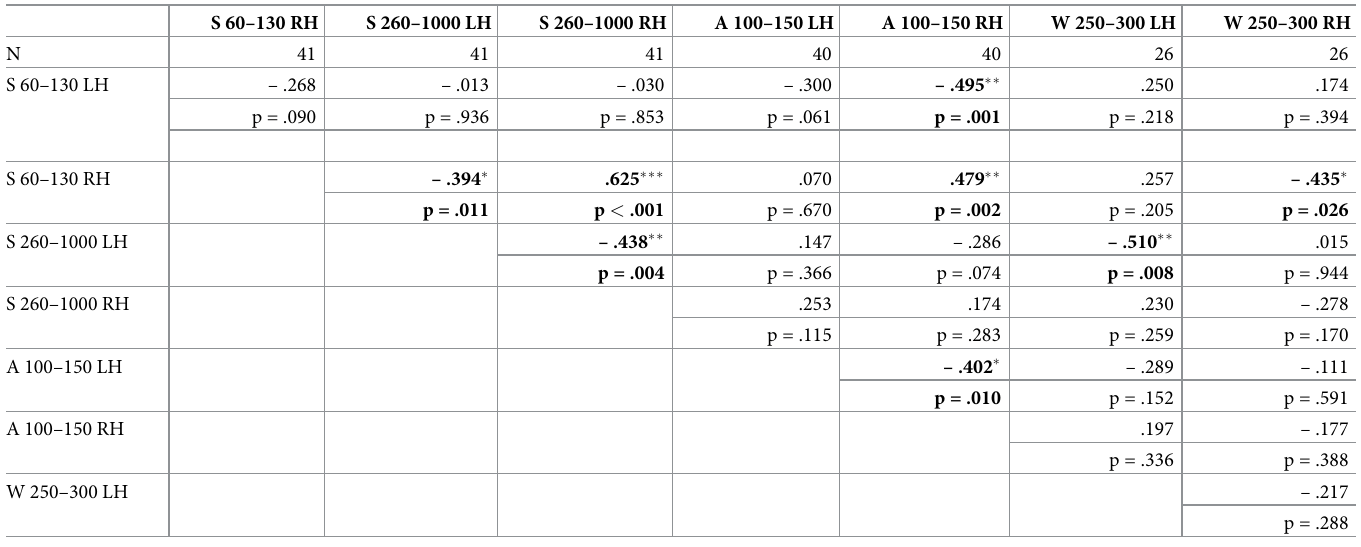
Table 16. Correlations between individual slopes across three experiments.